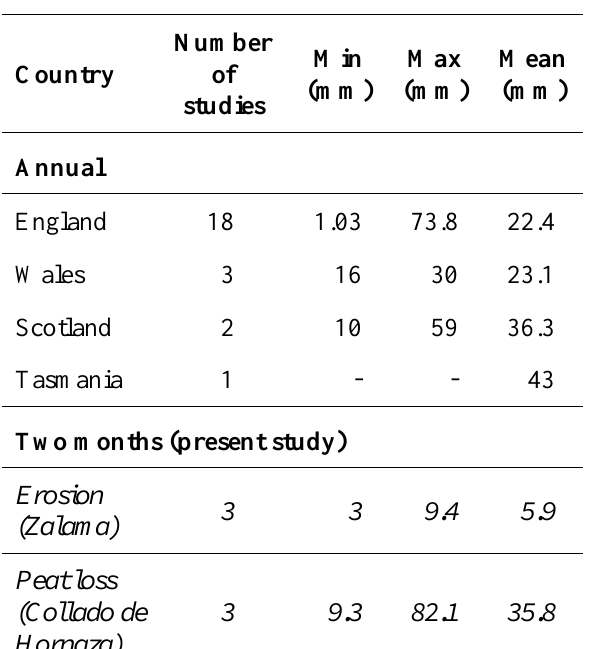
Table 6. Rates of erosion/peat loss determined over two months for three blanket bogs in north Spain compared to annual rates of peat erosion for England, Wales, Scotland and Tasmania (derived from Evans & Warburton 2007 and Li et al.